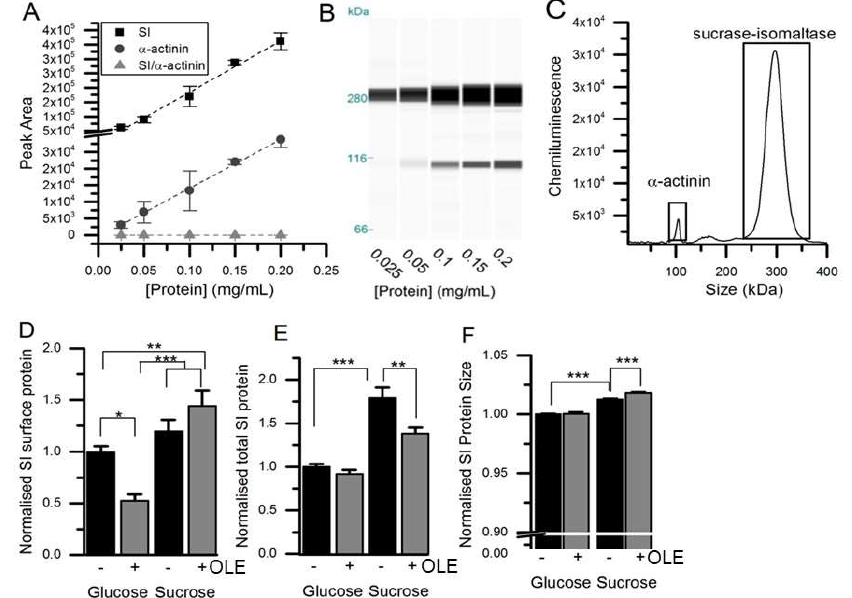
Figure 3. Detection and quantification of SI protein . (Panels A ) and (Panels B ) show the concentration- dependence of SI and α -actinin signals (Panel C ) using automated capillary Western blotting of Caco-2 / TC7 lysates. (Panel D ) shows Caco-2 / TC7 cell surface protein fraction purified after biotinylation from cells cultured on 6-well Transwell filters in glucose or sucrose for 21 days and treated on the apical side for the final 3 days with 1.5 mg / mL OLE. (Panel E ) shows the total cellular SI, relative to α -actinin with data normalised to the glucose control and presented as mean ± SEM with n = 12, analysed in duplicate runs. The size was determined relative to a protein standard ladder for SI in the total lysate relative to α -actinin ( F ), normalised and presented as mean ± SEM with n = 24. * p < 0.05, ** p < 0.01, *** p < 0.001 from ANOVA followed by Tukey’s post-hoc test. There was no change in the α -actinin loading control between the